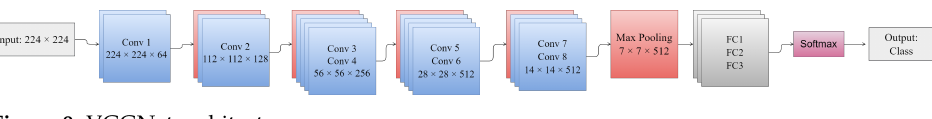
Figure 9. VGGNet